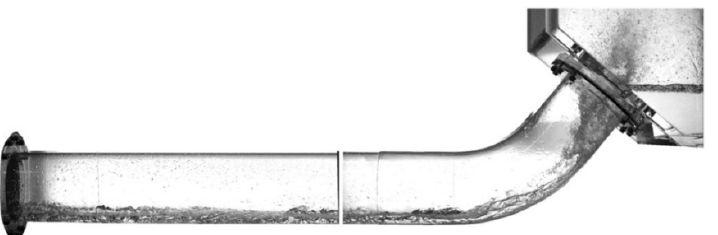
∗(cid:2869)/(cid:2870) = 0.305 L (cid:3013)